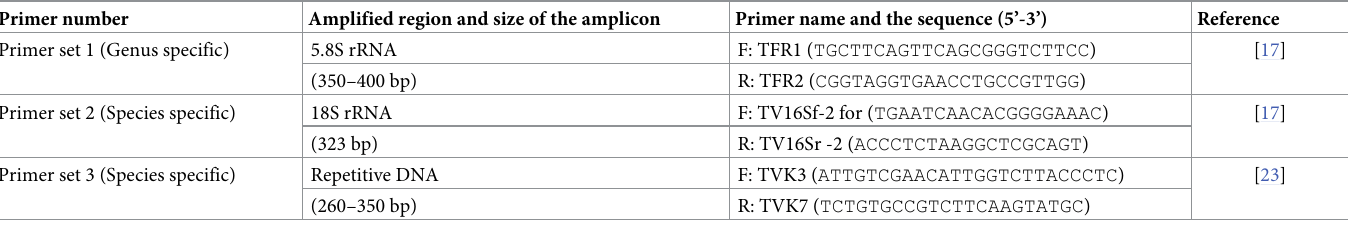
Table 1. Amplified regions and the genus-specific and the species-specific primers used in the